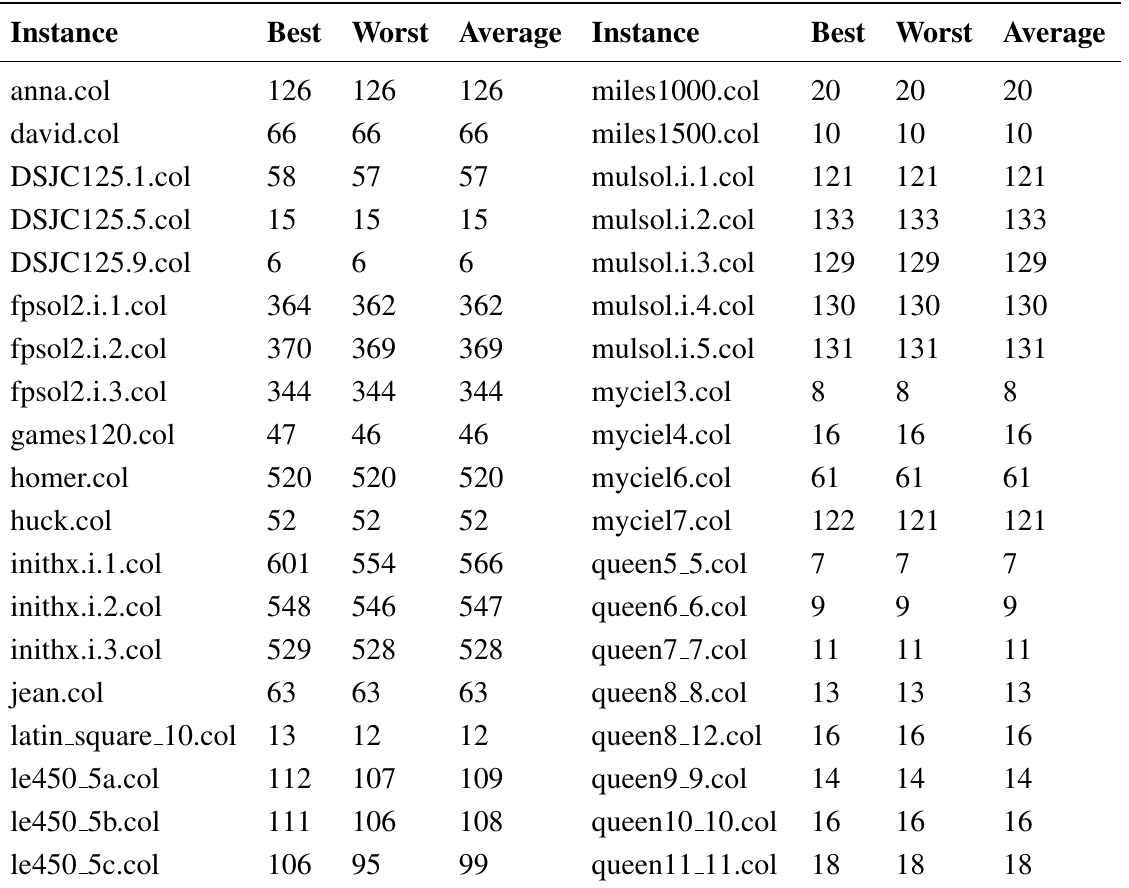
Table 4. Results for k-opt-LS and a CPU-time limit of 30 min for 15